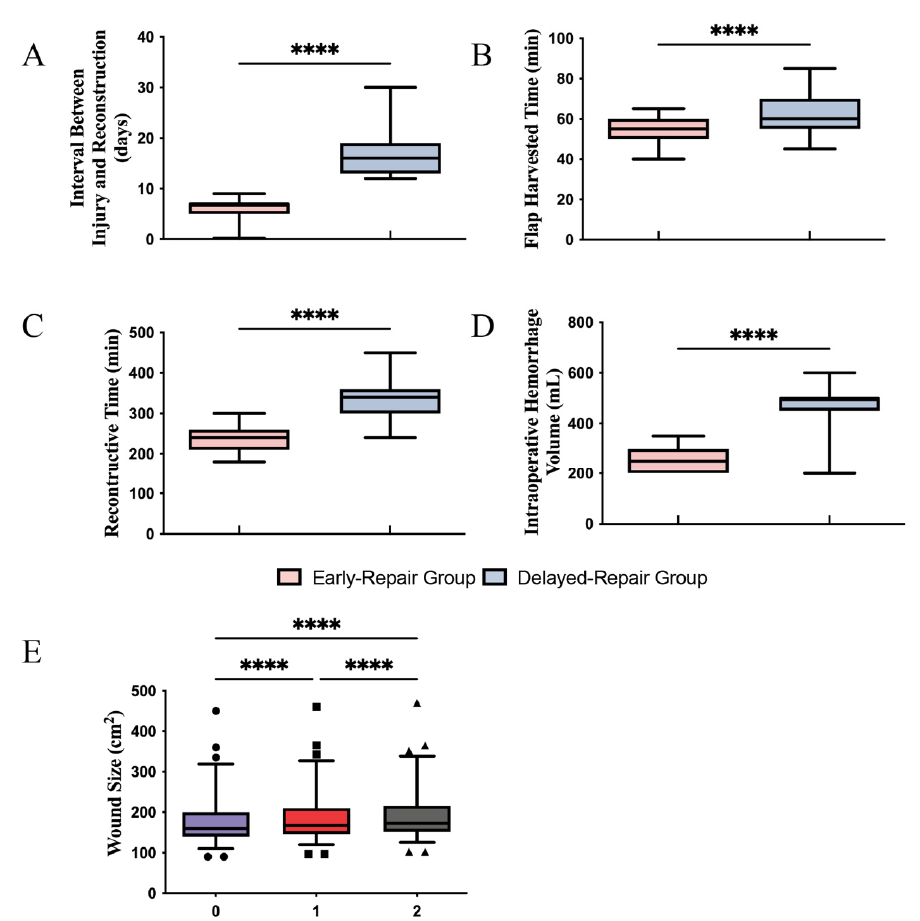
Figure 4. The perioperative conditions of early- and delayed-repair group. ( A ) The interval between injury and reconstruction was significantly longer in the delayed-repair group compared to early- repair group. ( B – D ) The surgical difficulty for delayed reconstruction was notably increased, which was reflected by prolonged flap harvest and reconstructive times, and increased intraoperative hemorrhage volumes in the delayed-repair group. ( E ) The wound size was gradually enlarged due to multiple debridements, with wound area increasing by an average of 8.20% after two debridements. **** p < 0.0001.